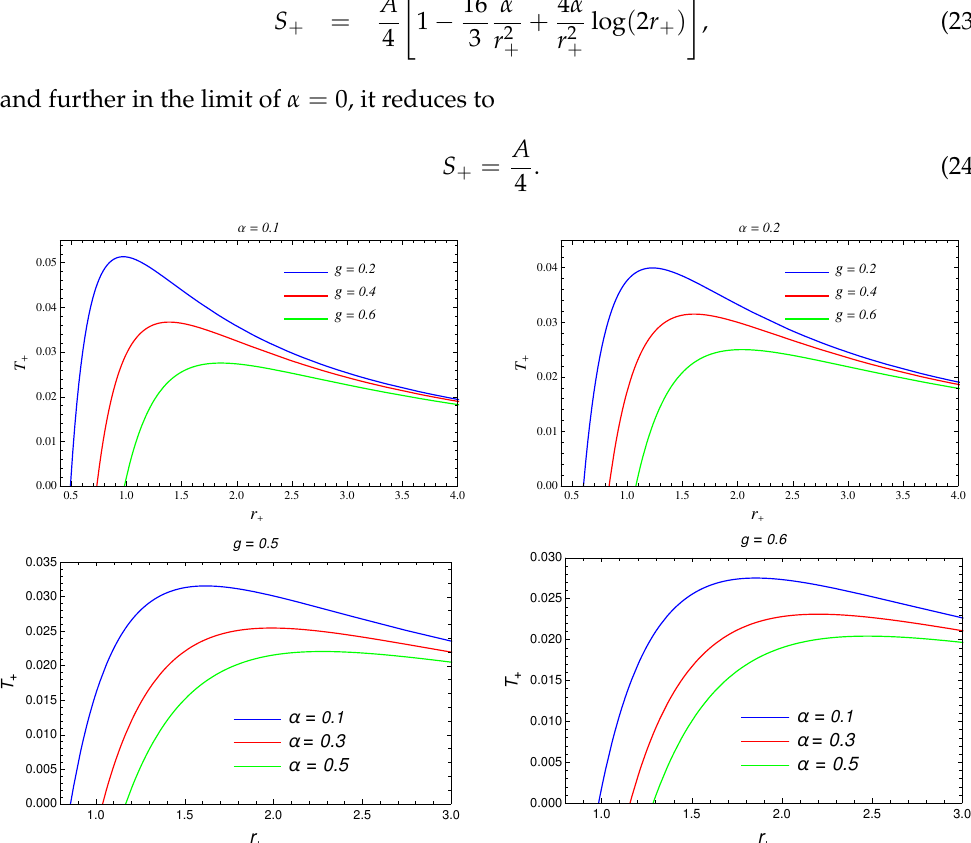
Figure 2. Hawking temperature T + vs horizon radius r + for various values of g and α . It is precisely the entropy of the Schwarzschild black hole and the area law holds. It is imperative to find the regions of the global stability of a thermodynamical system. Hence, we further study the behavior of Helmholtz’s free energy ( F + ) of our model. Helmholtz’s free energy determines the global stability of a thermodynamical system, such that a thermodynamical system with F + < 0 is globally stable, whereas the system with F + > 0 is globally unstable. The Helmholtz’s free energy of Bardeen black holes in 4 D EGB